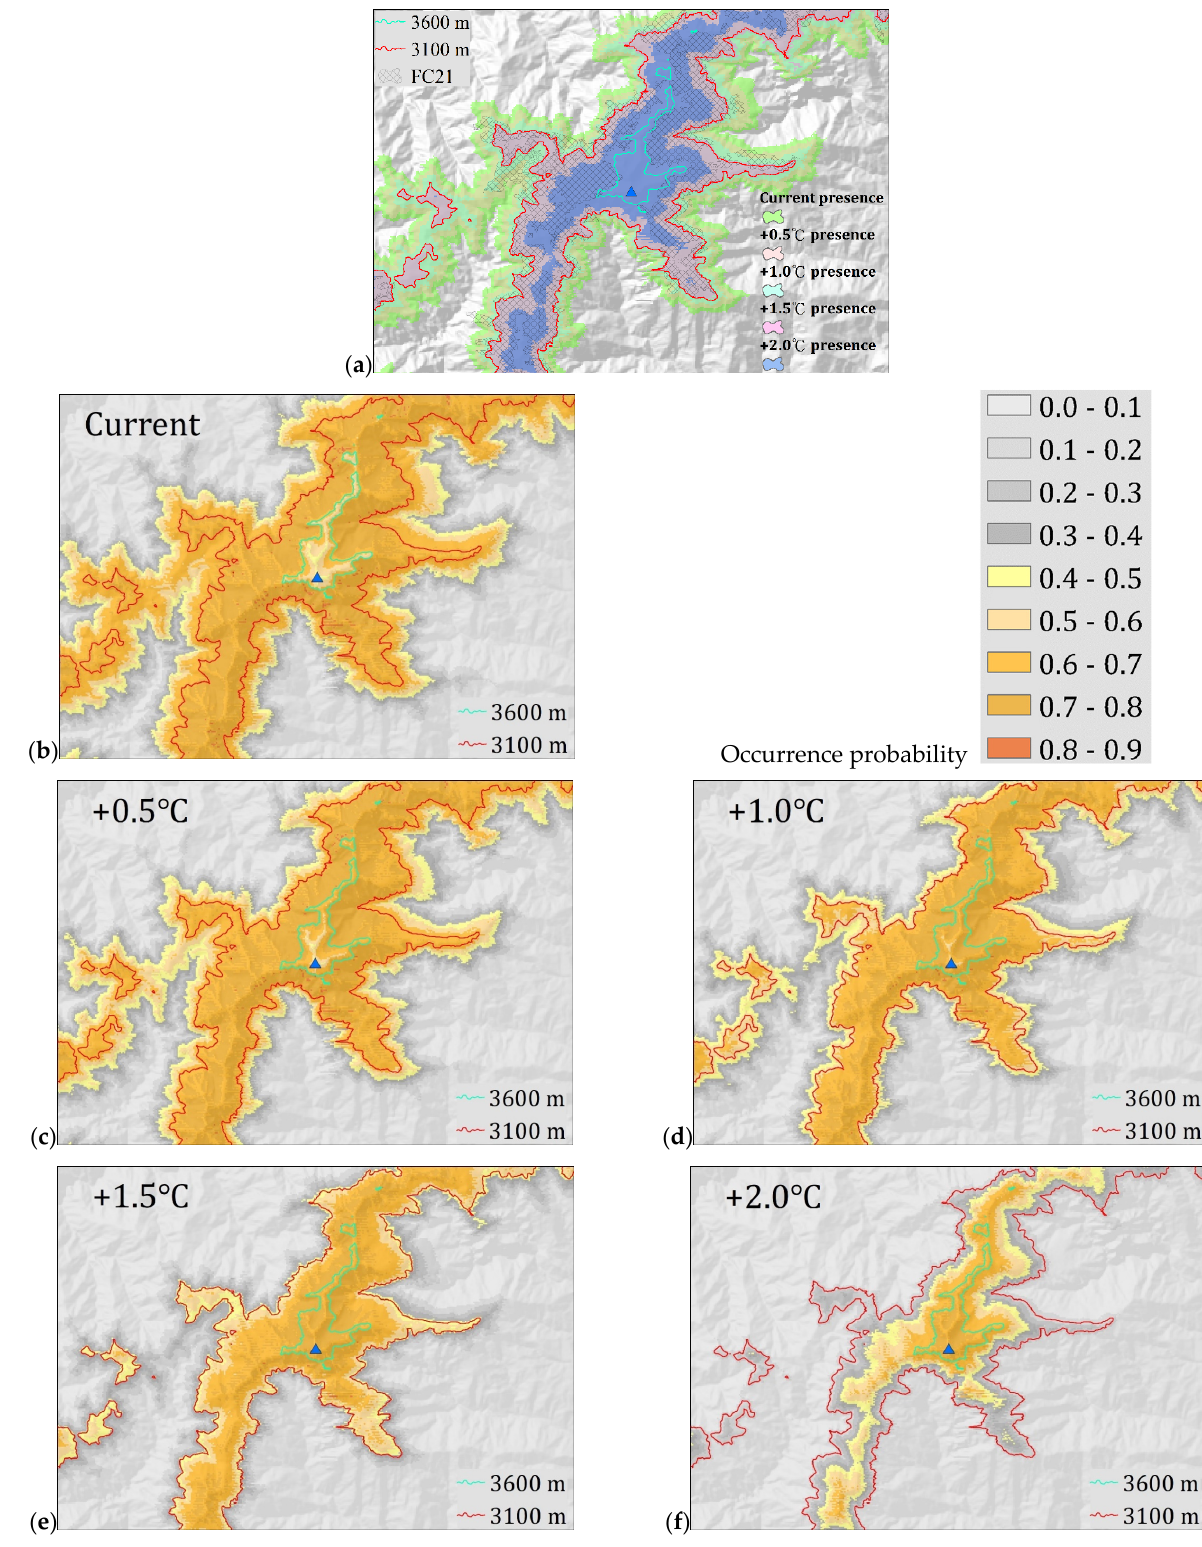
Figure 4. Changes in suitable habitat areas of A. kawakamii on Mount Xue ( a ) under different climate warming scenarios, ( b ) current climate, ( c ) under the +0.5 °C scenario, ( d ) under the +1.0 °C scenario, ( e ) under the +1.5 °C scenario, and ( f ) under the +2.0 °C scenario.